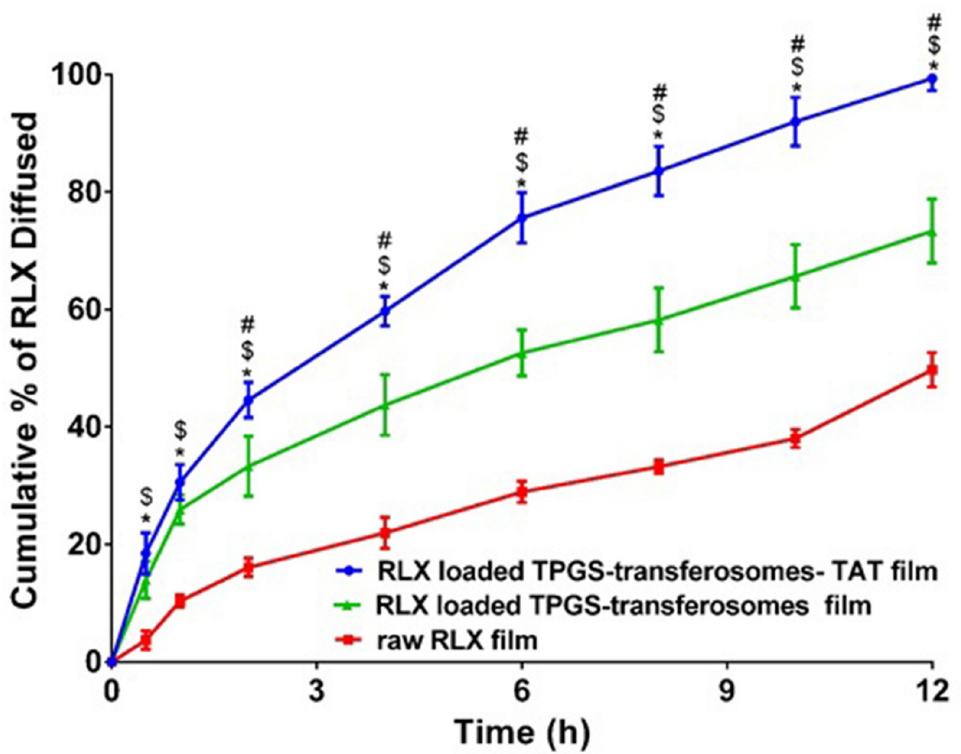
Fig 4. Permeation of raw RLX transdermal film, RLX-TPGS-transferosomes film and RLX-TPGS-transferosomes- TAT film through rat skin. Notes: Value indicate the mean ± SD (n = 3). # p < 0.05 RLX-TPGS-transferosomes-TAT compared to RLX-TPGS-transferosomes formula; � p < 0.05 RLX-TPGS-transferosomes-TAT compared to raw RLX; $ p < 0.05 RLX-TPGS-transferosomes formula compared to raw